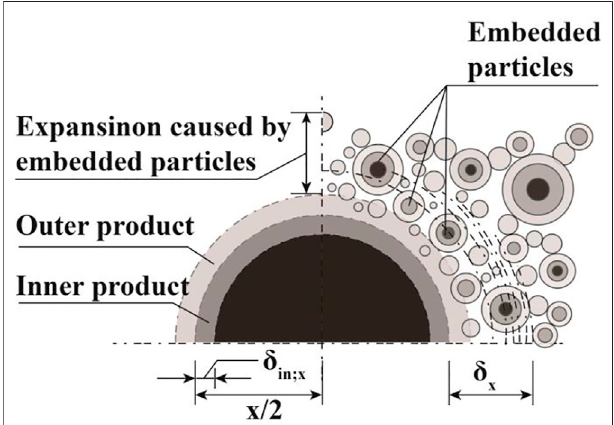
FIGURE 1 | Schematic illustration of the growth mechanism of the HYMOSTRUC model (Courard, 2005). The left part shows the growth of a single cement particle and the formation of inner and outer products; the right part shows the embedding of small cement particles in the outer shell of a large cement